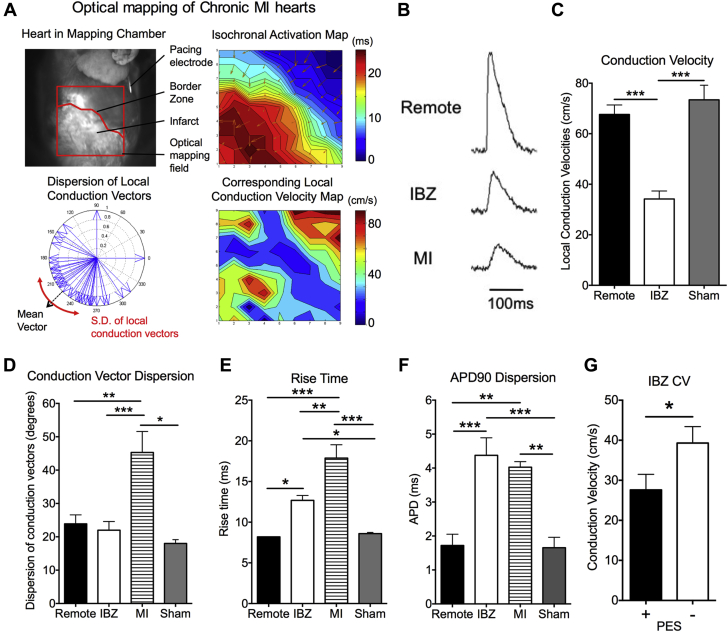
Electrophysiological and Arrhythmia Determinants of Chronic MI Model(A) Optical mapping of chronic MI hearts. (B) Representative optical action potentials from remote myocardium, IBZ, and infarct zone. (C) Slower CVs at IBZ compared with remote myocardium. (D) Conduction vector angles were more heterogeneous in the infarct zone (MI). (E) Prolonged rise times at the infarct zone and IBZ. (F) Increased dispersion of optical APDs at the infarct zone and IBZ. (C to F) n = 16 for MI hearts, and n = 4 for sham hearts. (G) IBZ CV was slower in PES(+) hearts (n = 8) than in PES(−) hearts (n = 8). *p < 0.05; **p < 0.01; ***p < 0.001. APD = action potential duration; CV = conduction velocity; IBZ = infarct border zone; PES = programmed electrical stimulation.